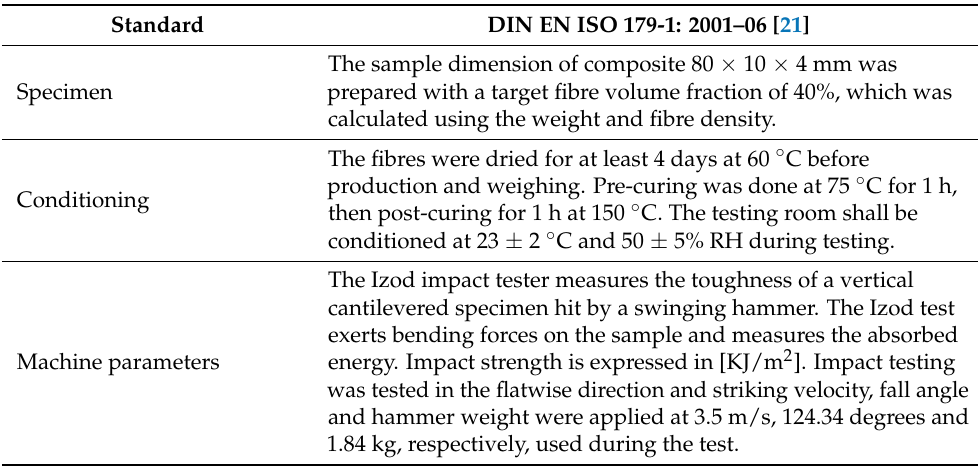
Table 1. Standard methods of measuring unnotched impact